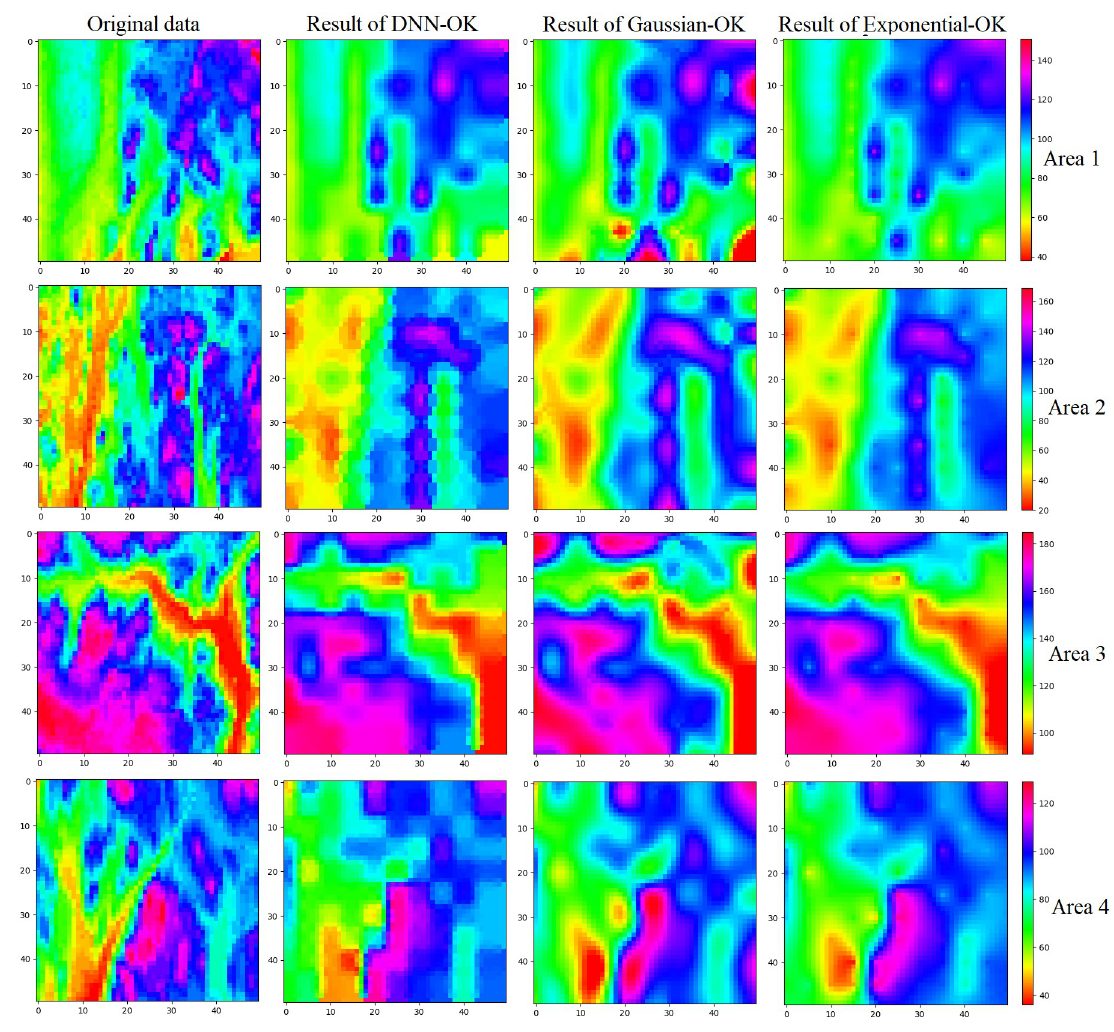
Fig 1. Semivariogram fitting of the DNN model with different training times.